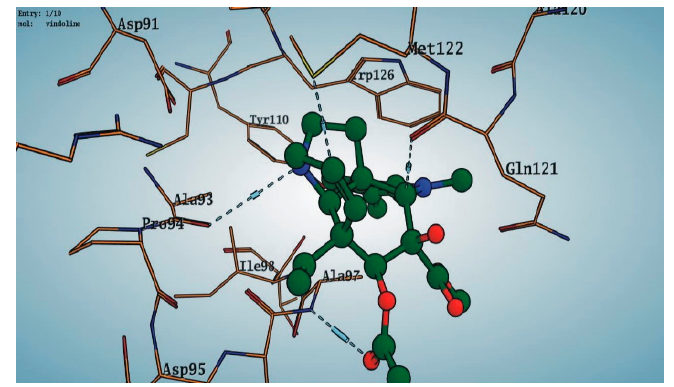
Figure 7. 3D interaction of most active compound 14 (Nummularine-R).